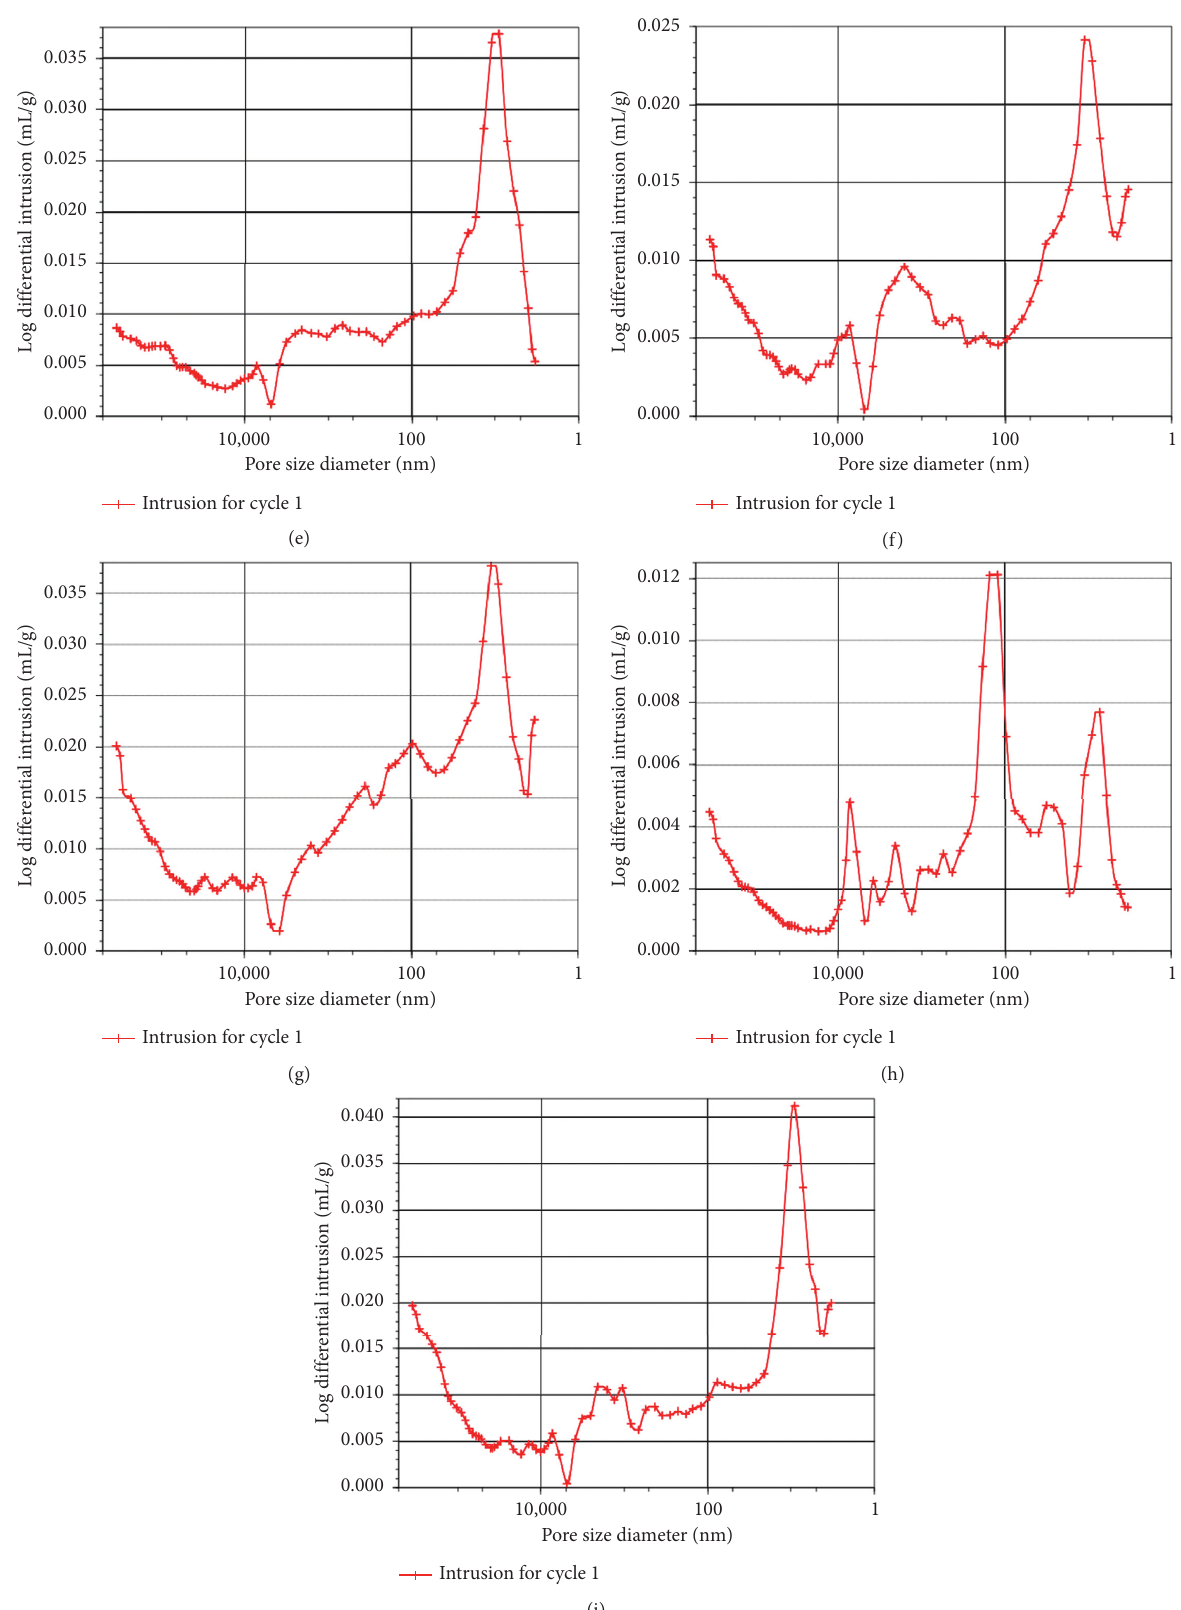
Figure 5: Aperture distribution diagrams. (a) A 1 B 1 C 1 D 1 , (b) A 1 B 2 C 2 D 2 , (c) A 1 B 3 C 3 D 3 , (d) A 2 B 1 C 2 D 3 , (e) A 2 B 2 C 3 D 1 , (f) A 2 B 3 C 1 D 2 , (g) A 3 B 1 C 3 D 2 , (h) A 3 B 2 C 1 D 3 , and (i) A 3 B 3 C 2 D 1